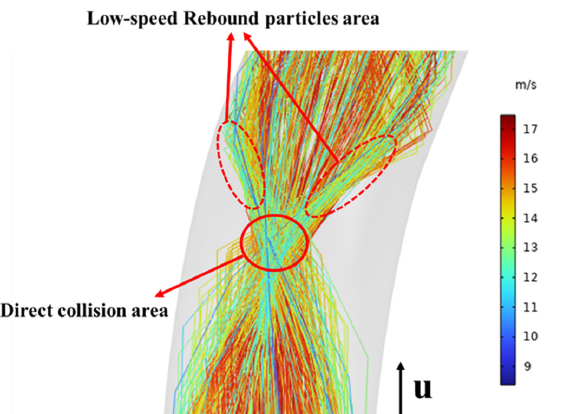
Figure 10. Collision trace diagram of particles and outer sidewall surface of elbow and V-type collision trace of low-speed particles.